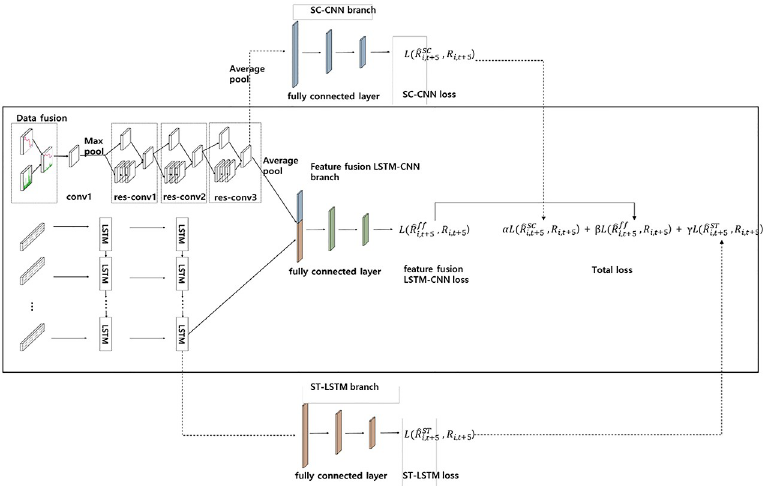
Fig 11. The architecture of proposed feature fusion LSTM-CNN model comprised of SC-CNN and ST-LSTM models.